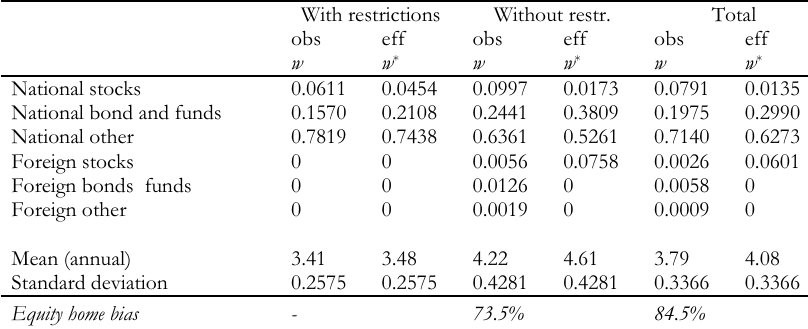
Observed and efficient